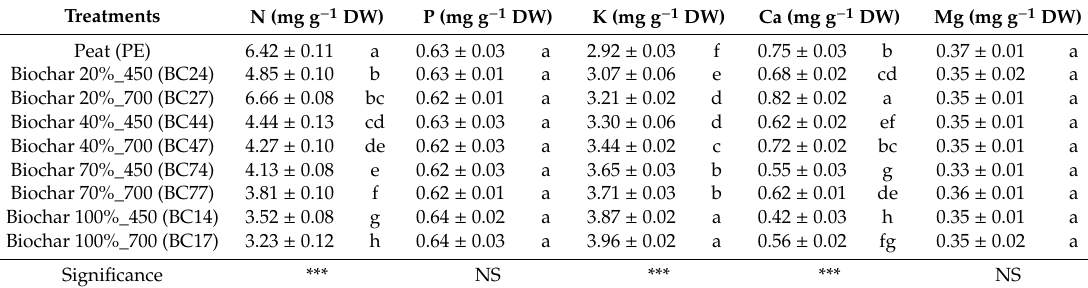
Table 5. Analysis of variance and means comparisons for leaves N, P, K, Ca and Mg content of curly endive cultivated on di ff erent growing substrates in a protected